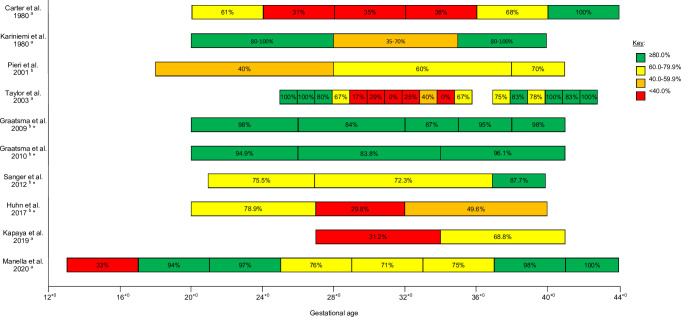
Device performance of fetal electrocardiography devices at different fetal gestational ages (weeks).The device performance (success rate or signal quality) for each study was extracted and reported in the figure using both the numerical value and a coloured key as a visual aid: green (≥80.0%), yellow (60.0–79.9%), orange (40.0–59.9%) and red (<40.0%). Four studies reported data only using a figure, hence data reported were extracted from the original figures either by drawing a line to the axis (Carter et al. and Graatsma et al. (2009)), or by dividing the number of successful recordings by the total number of recordings (Manella et al. and Taylor et al.). Kariniemi et al. did not provide a specific gestational age for “term”; for the purpose of this figure, term was assumed to be 40+0 weeks’ gestation. Numerical values reported are as presented in the studies, or to the nearest whole number if extrapolated from a figure. a Values represent success rate (as reported by authors). b Values represent signal quality. * Studies which used the Monica AN24 device.